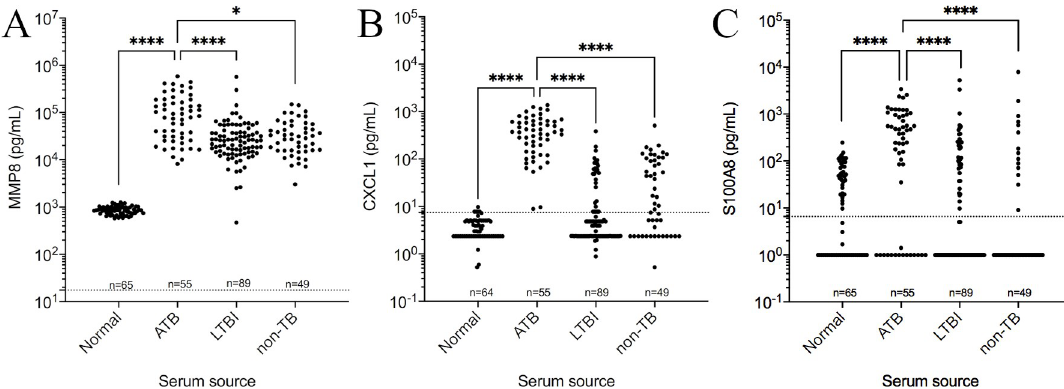
Fig 7. MMP8, CXCL1 and S100A8 protein levels in human sera from patients with active pulmonary TB (ATB), latent Mtb infection (LTBI), non-TB disease and normal individuals. We tested serum from HIV-negative patients ATB, LTBI, non-TB disease and replicates from pooled normal for MMP8 (A), CXCL1, (B) and S100A8 (C) by ELISA, and analyzed data by Kruskal-Wallis one- way ANOVA with Dunn’s multiple comparisons post-tests ( � < 0.05, ���� p < 0.0001). Dashed lines show the limits of detection (LOD): MMP8 LOD = 17.47 pg/mL, CXCL1 LOD = 7.46 pg/mL, and S100A8 LOD = 6.59 pg/mL.